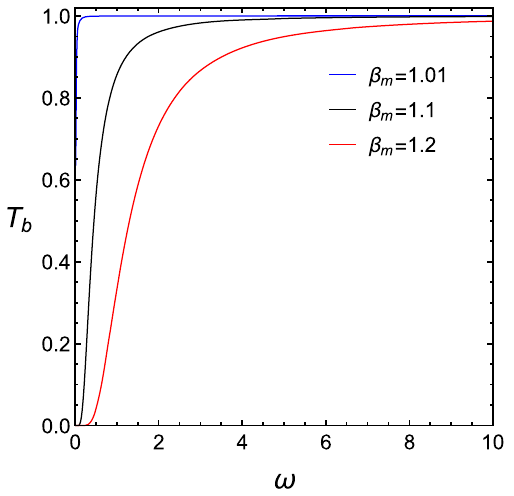
Fig. 5 Plot of T b using different values of β m , with (cid:16) = 0 , M = 1 and c 2 = −